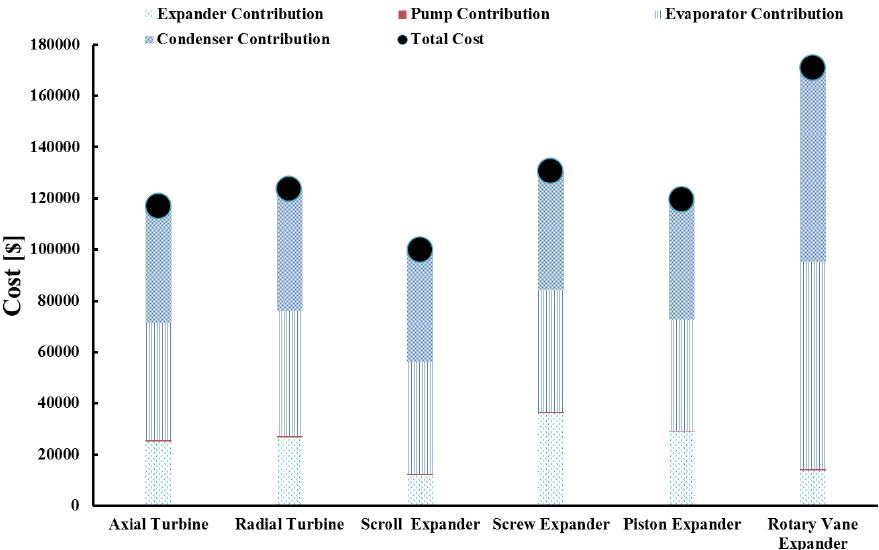
Figure 15. Cost estimation of different expanders based on their corresponding systems.